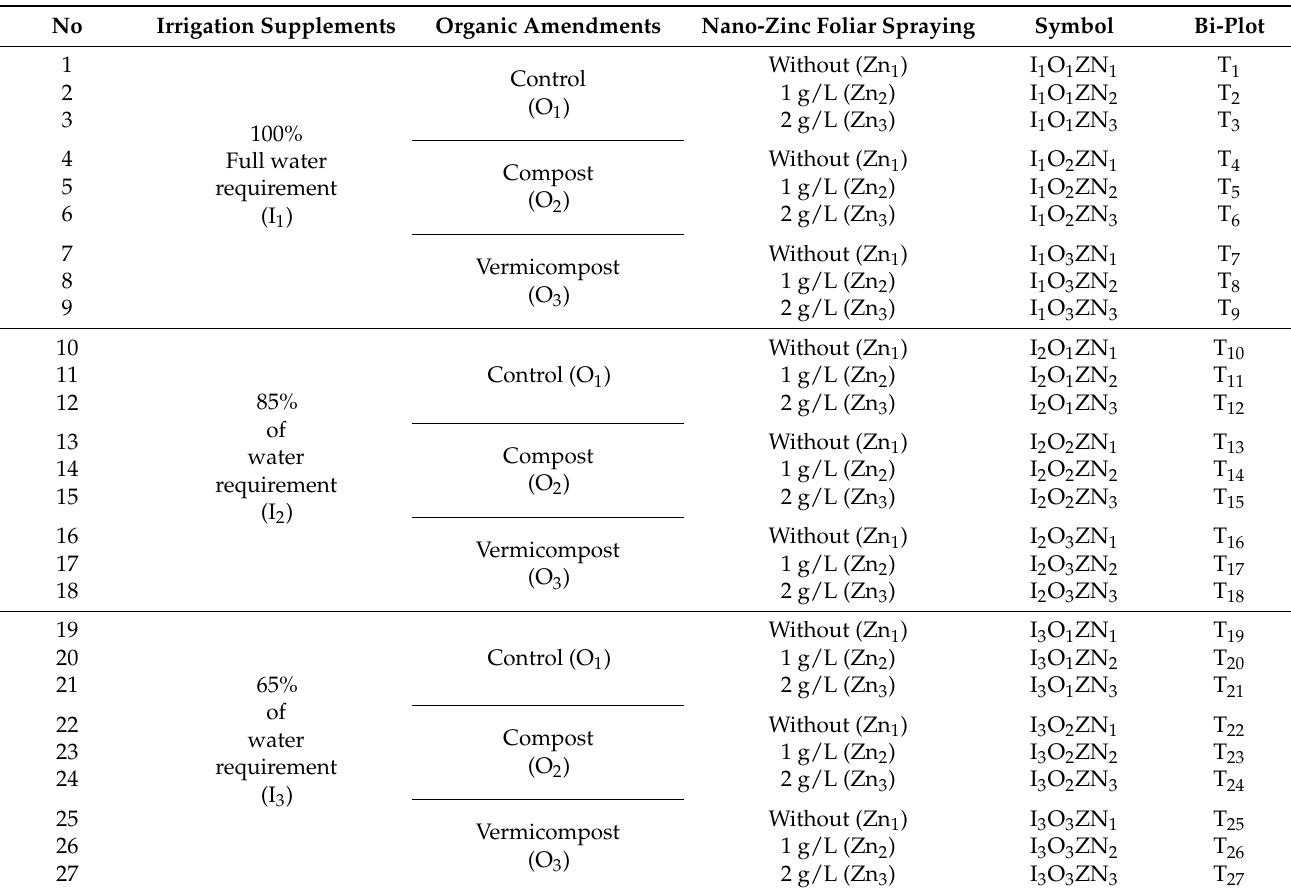
Table 3. Description of the used factorial treatments and their